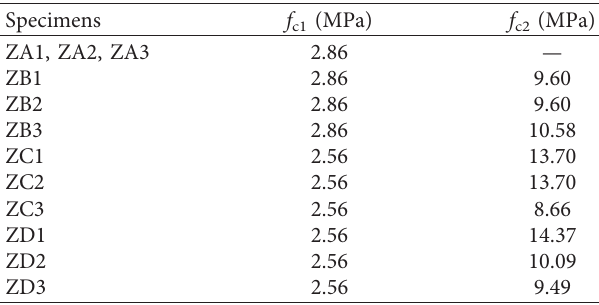
Table 4: Compressive strength of mortar. Specimens